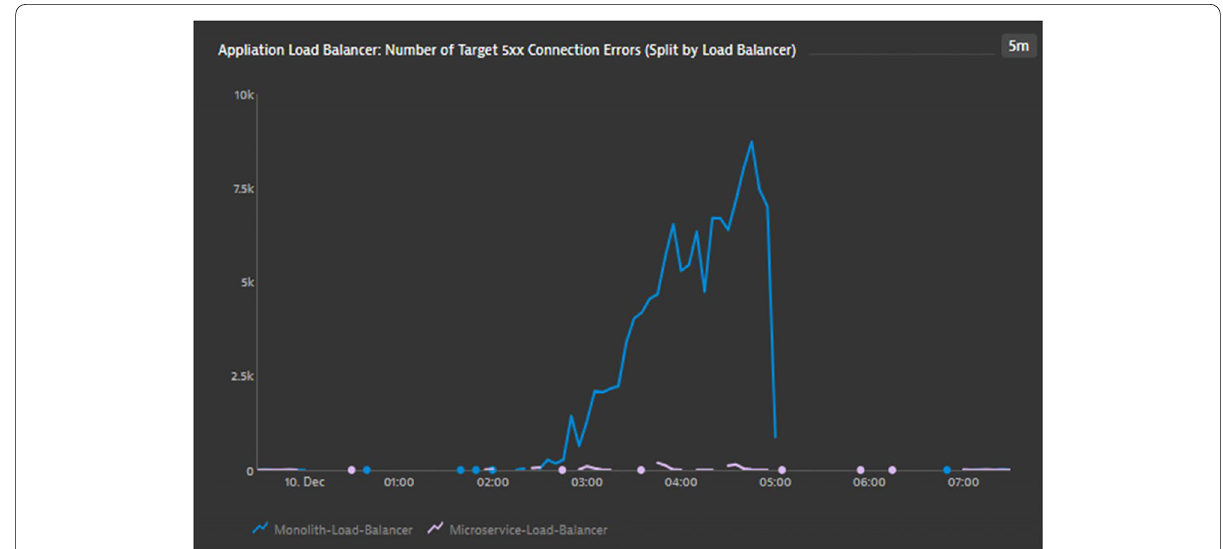
Fig. 16 Total number of 5xx errors, split by load